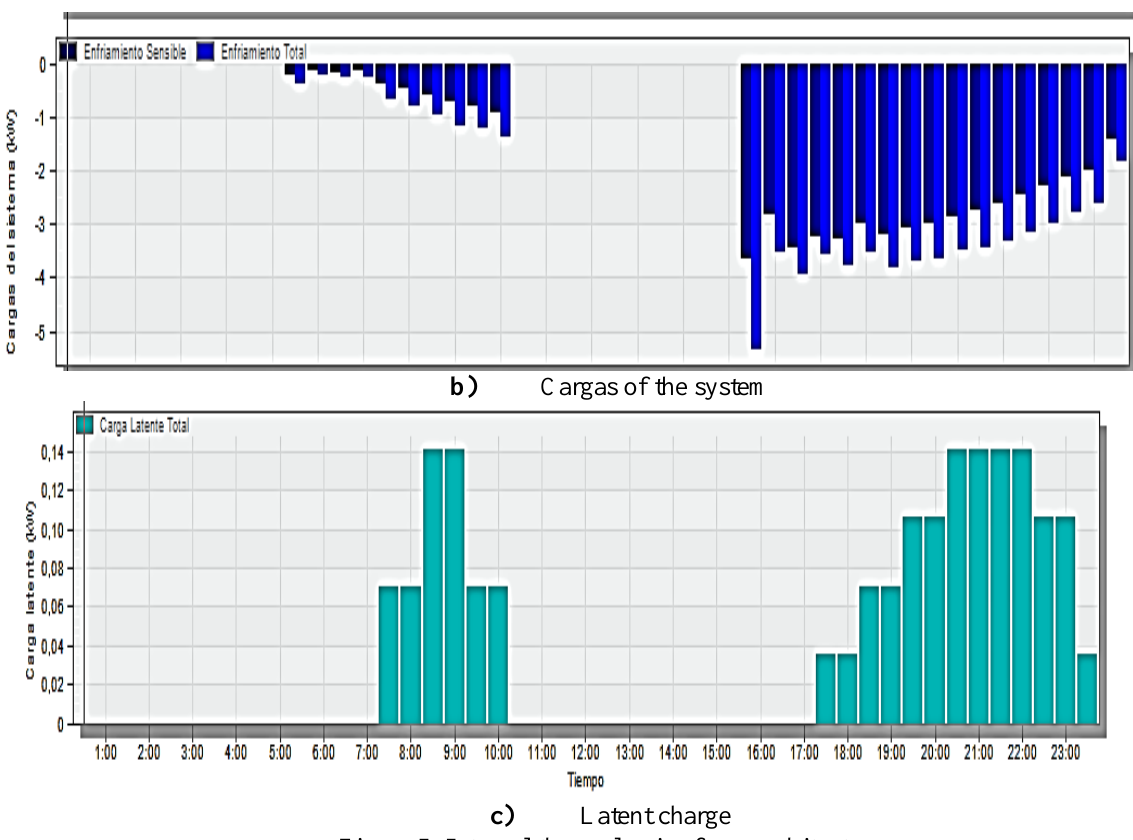
Figure 5. Internal thermal gains from architecture